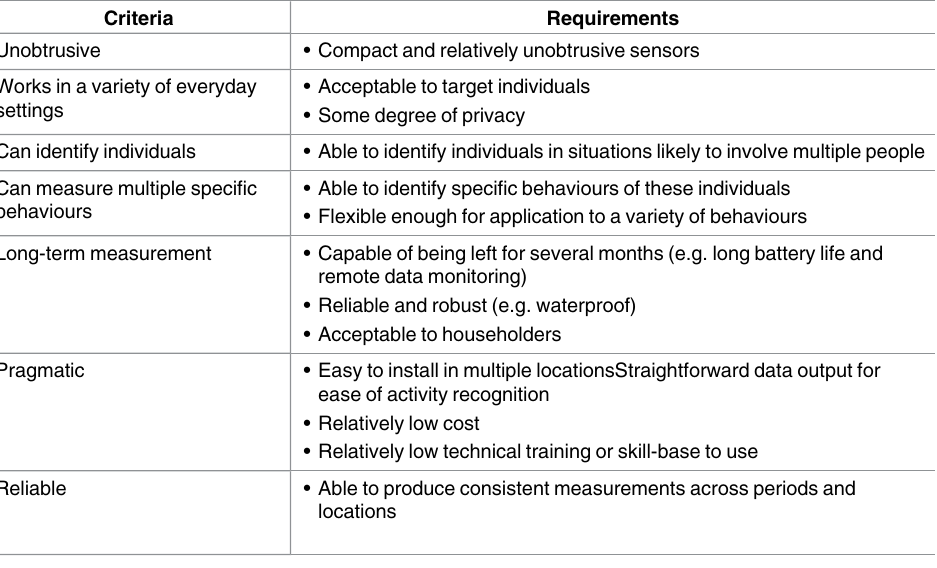
Table 1. Desirablecharacteristics of a behaviour monitoring